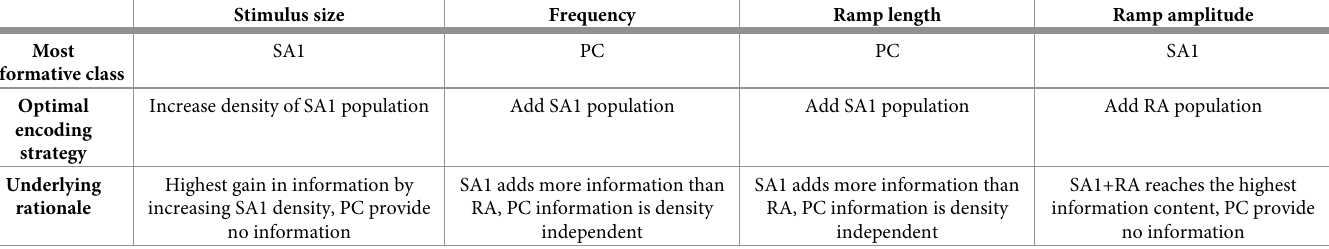
Table 1. Information maximizing encoding strategies for each stimulus feature trading off increases in innervation density for a single afferent class versus adding fibers from a different